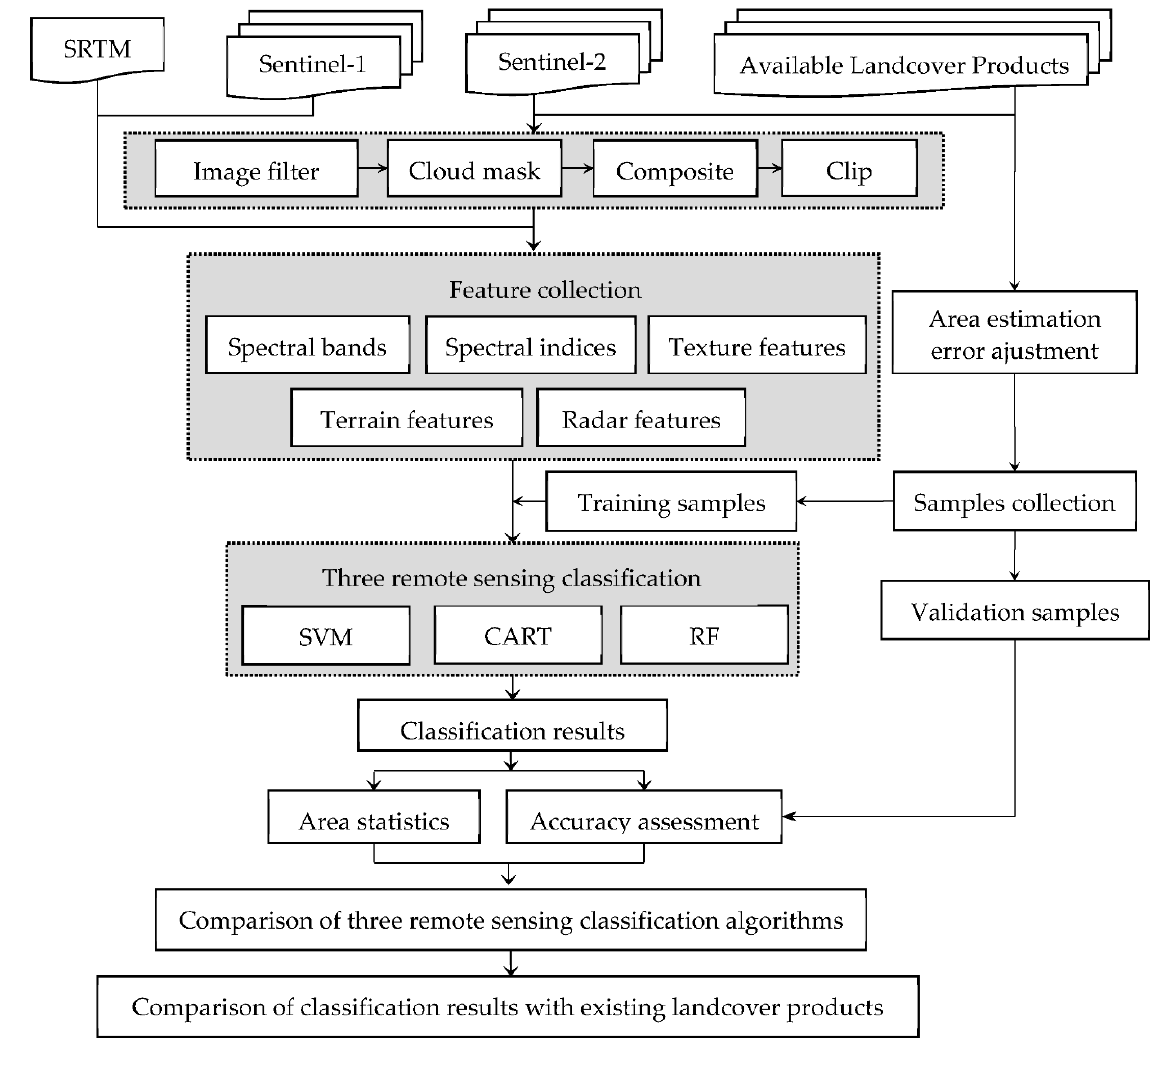
Figure 2. Flow diagram of data processing and analysis.